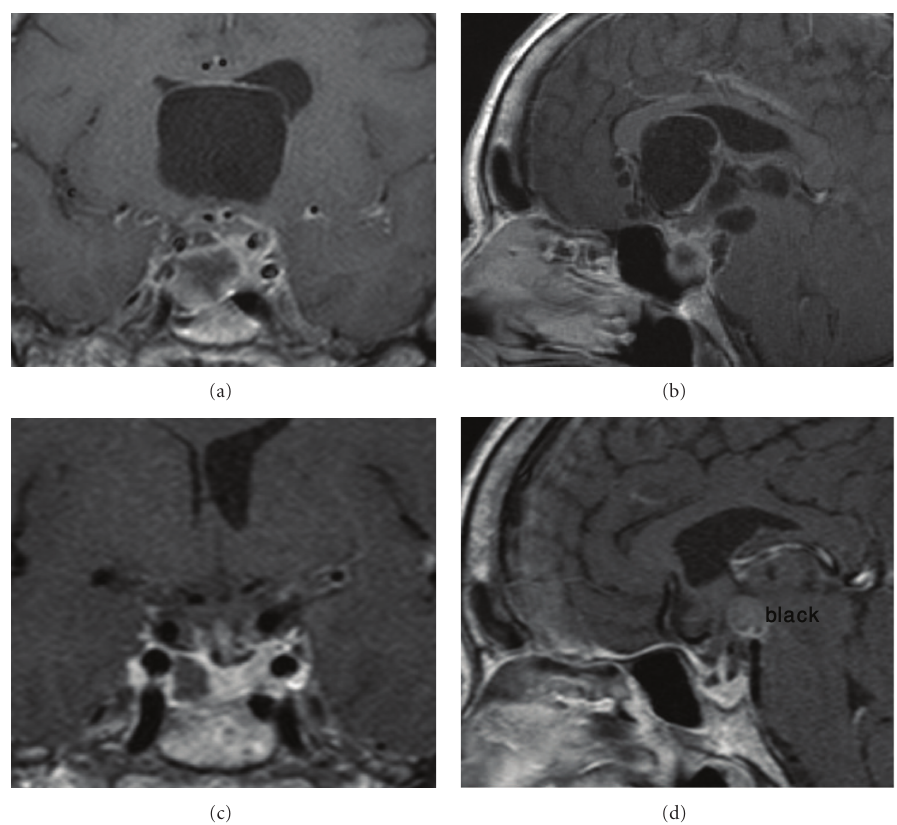
Figure 1: Preoperative. Coronal (a) and sagittal (b) T1-weighted MRI with gadolinium enhancement showing multiple cysts in the sellar, suprasellar regions, third ventricle, and basal cisterns. There is heterogenous contrast enhancement around the left anterior clinoidal process and in the sella turcica. Postoperative coronal (c) and sagittal (d) T1-weighted MRI with gadolinium enhancement showing partial empty sella, resection of the pituitary adenoma, anterior clinoidal meningioma, and the